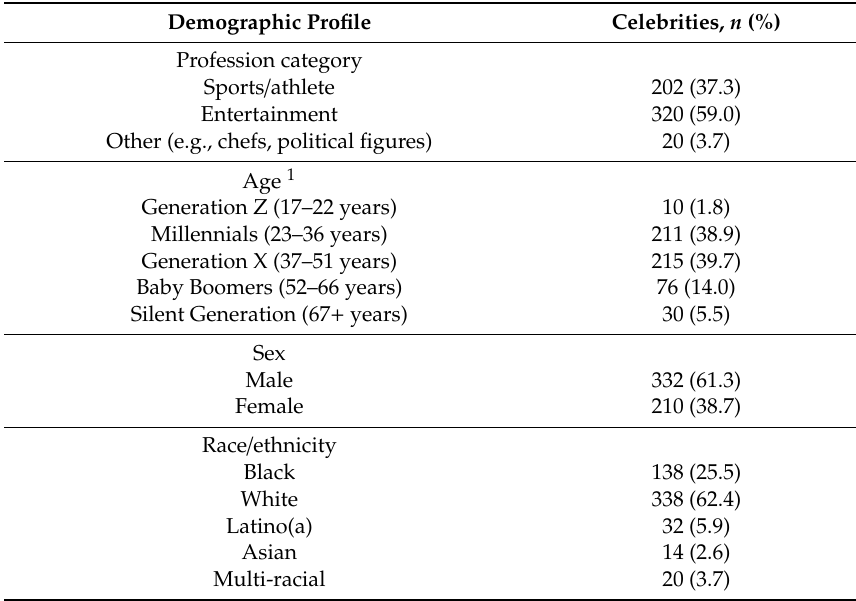
Table 3. Demographic profiles of celebrities ( n = 542) who endorsed food and beverage products or brands in the US between 1990 and